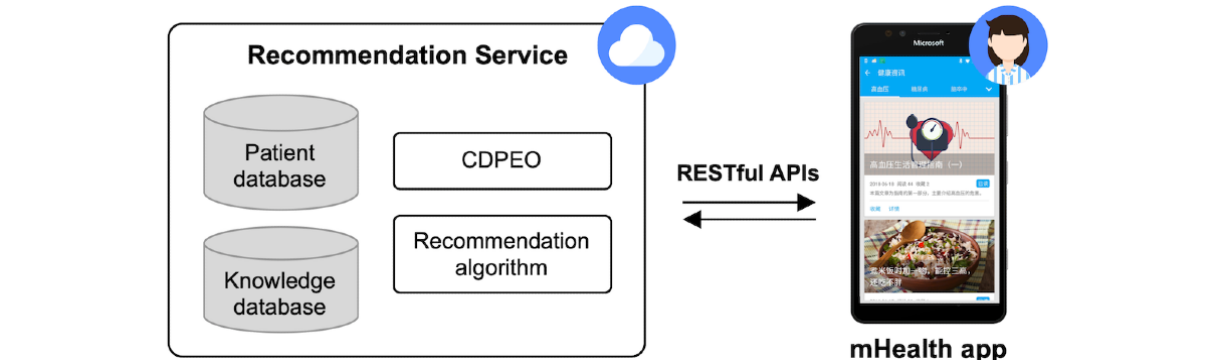
Figure 12. Structure of the